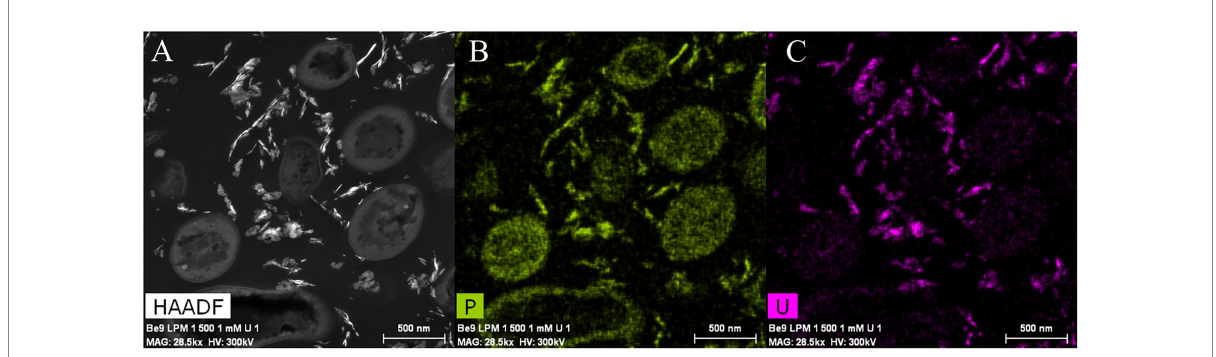
FIGURE 8 High angle annular dark-field-scanning transmission electron microscopy (HAADF-STEM) image of Microbacterium sp. Be9 cells after incubation under MC3 treatment (0.2 mg/l peptone concentration and 1 mM U) (A) ; EDX element mapping for P (B) and U (C)